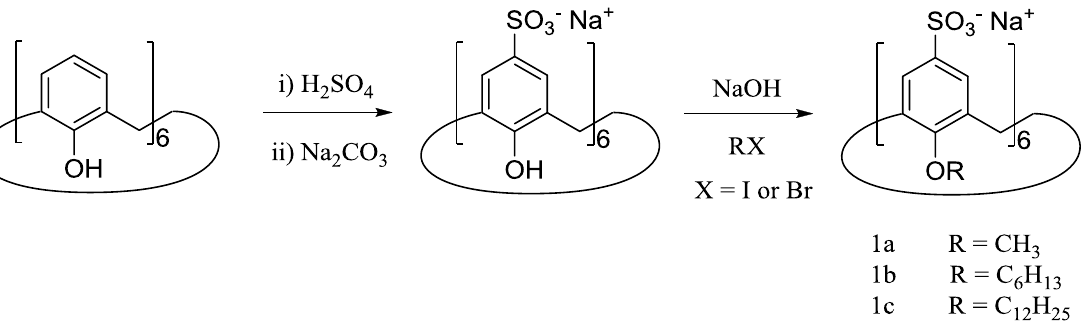
Figure 2. Synthesis of alkylated p -sulfonatocalix[6]arenes.